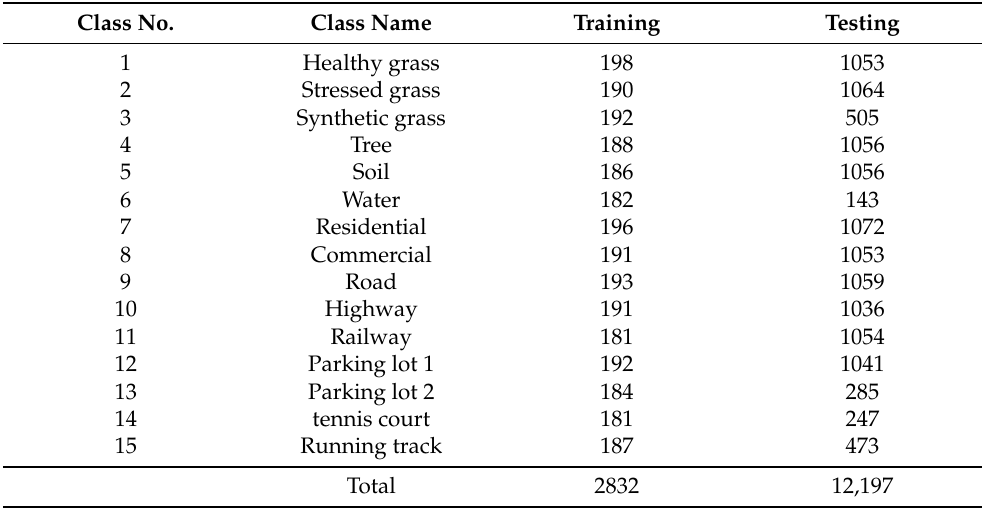
Table 4. Number of training and testing samples for the different classes in Houston Univer- sity dataset.